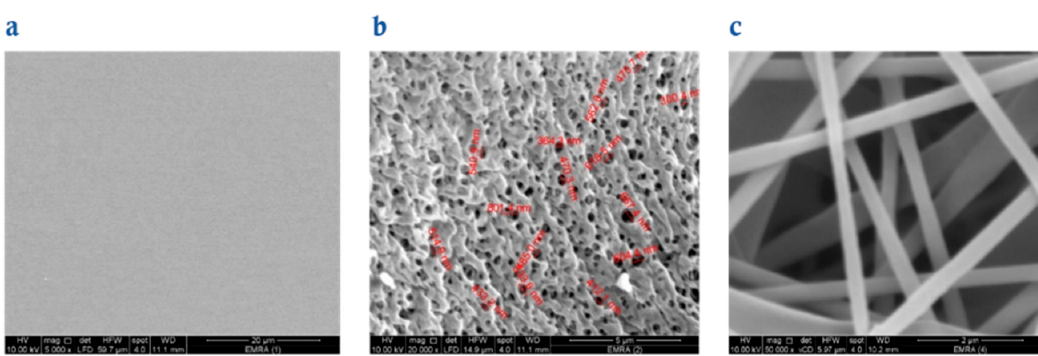
Figure 1. Scanning Electron Microscopy (SEM) images of the prepared cellulose acetate materials as: ( a ) casted film, ( b ) porous membrane, and ( c ) nanofibers from dimethylformamide (DMF).